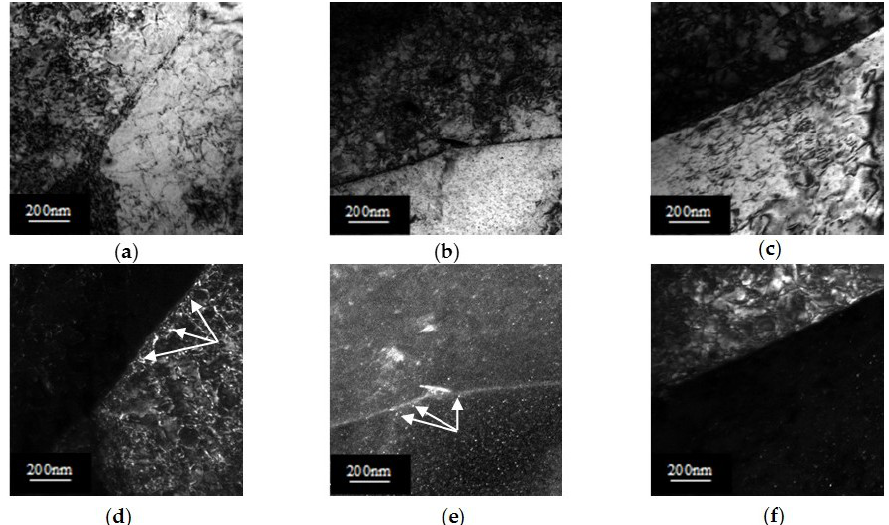
Figure 4. TEM micrographs of LCHB steel showing the dislocation network distribution with precipitates close to the grain boundaries, ( a ) bright field image of steel rolled at RT = 790 °C, ( b ) bright field image of steel rolled at RT = 830 °C, ( c ) bright field image of steel rolled at RT = 870 °C, ( d ) dark field image of steel rolled at RT = 790 °C, ( e ) dark field image of steel rolled at RT = 830 °C, ( f ) dark field image of steel rolled at RT = 870 °C. The precipitates are indicated by arrows.